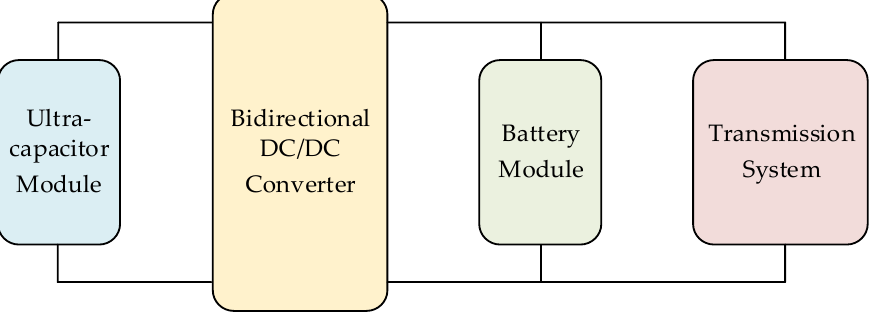
Figure 1. System topology.